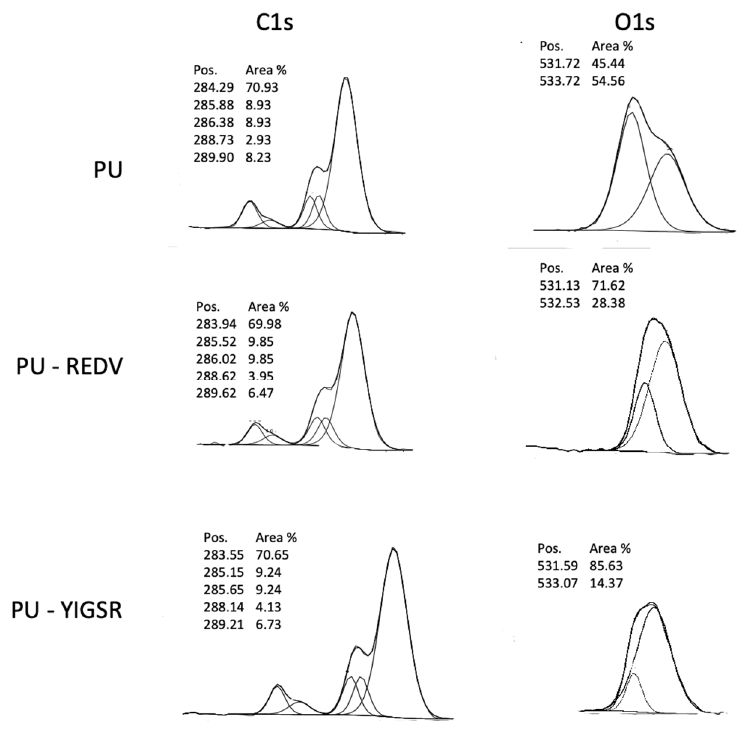
Figure 4. X-ray photoelectron spectroscopy (XPS) spectra of carbon C1s and O1s.